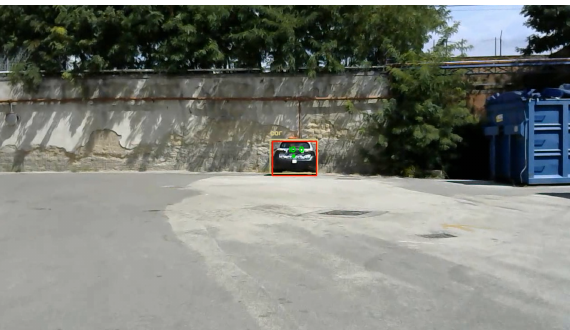
Figure 7. Example of captured image frames from CCRS scenario video.